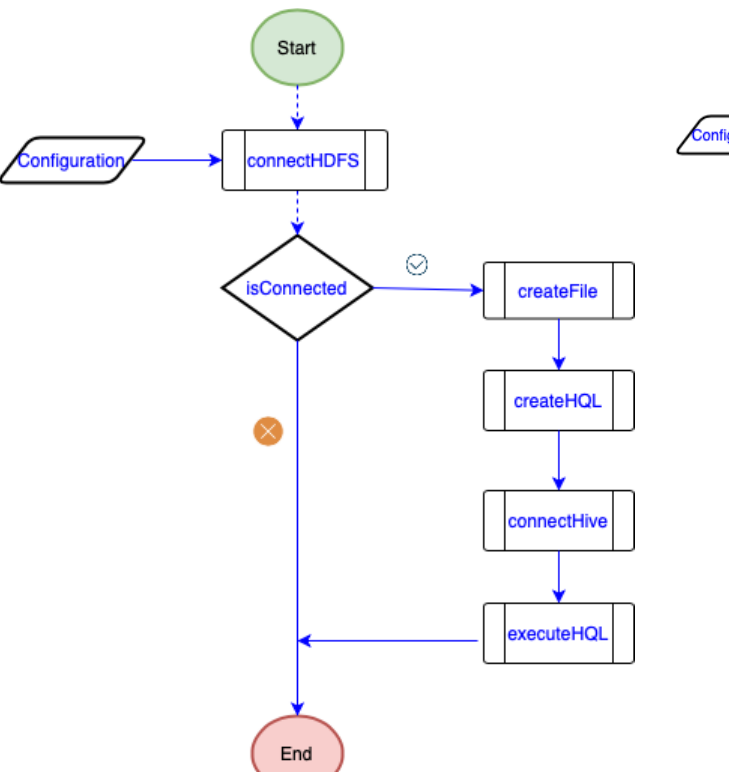
Figure 5. Steps integrating ArcMap toolbox with Hive engine